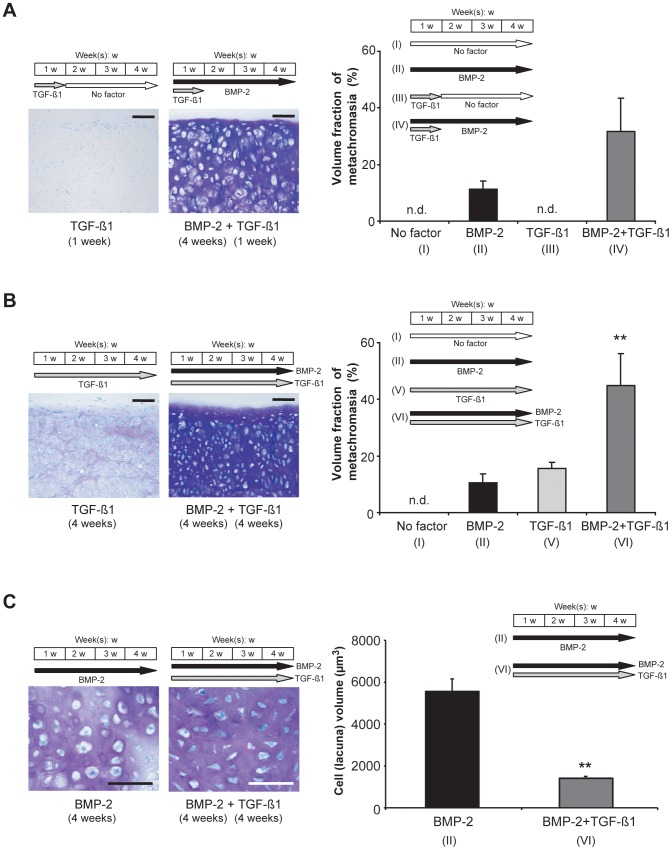
Influence of TGF-ß1 on the BMP-2-induced chondrogenesis of synovial explants (histochemical and histomorphometric analysis).A, B: Light micrographs of Toluidine-Blue-stained sections through bovine explants that had been cultured for 4 weeks under the indicated stimulation conditions (left), and graphs depicting the volume fraction of metachromasia in each case (right). BMP-2 was applied at a concentration of 200 ng/ml, and TGF-ß1 at one of 10 ng/ml. C: Light micrographs (left) of Toluidine-Blue-stained sections through bovine synovial explants that had been cultured for 4 weeks in the presence either of BMP-2 alone or of the TGF-ß1/BMP-2 combination, illustrating the size difference between the cell (lacuna) profiles in each case. The average cell (lacuna) volume was estimated histomorphometrically (right). Mean values for n = 4 animals (4 explants in each case) are represented together with the SEM. n.d.: not detectable; **: p<0.01 vs. “BMP-2”. Bars = 100 µm.